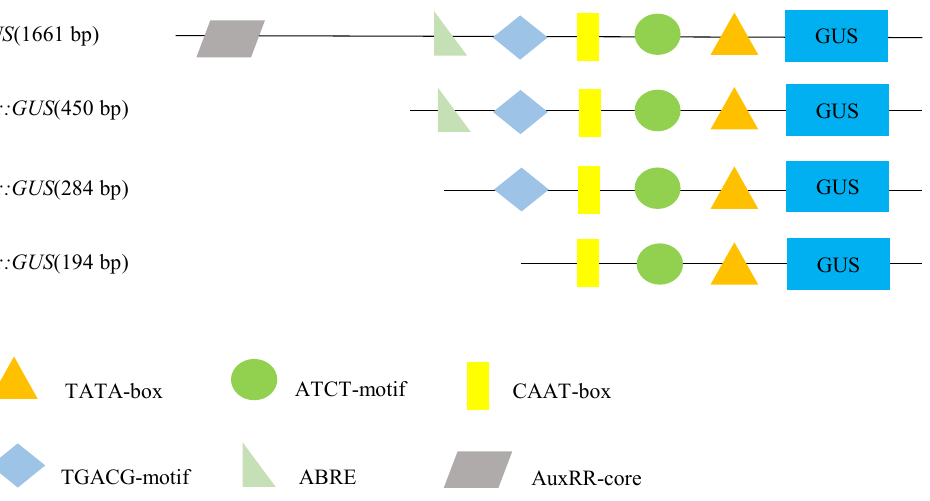
Figure 2. Construction of the recombinant expression vector of the PGmRIQ2 deletion fragment. Table 2. Media for soybean cotyledon node transformation